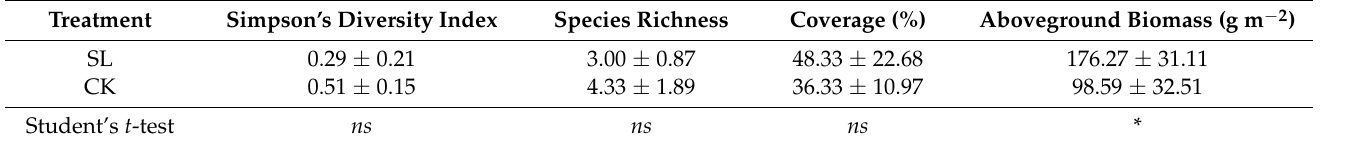
Table 2. Effects of sewage sludge (SS) application on Simpson’s diversity index, species richness, coverage, and aboveground biomass within a 0.5 m × 0.5 m quadrat.